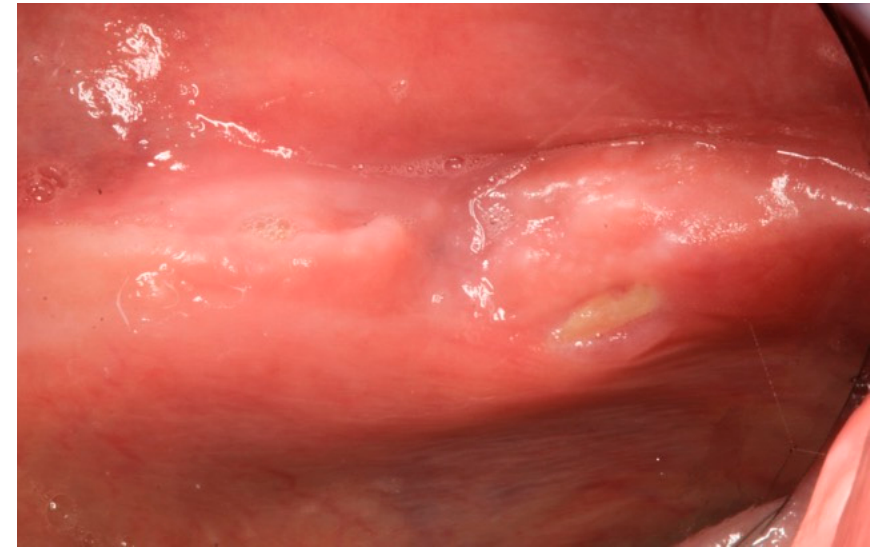
Figure 1. Case 1: Intraoral aspect of the bone exposition on left the mylohyoid line.